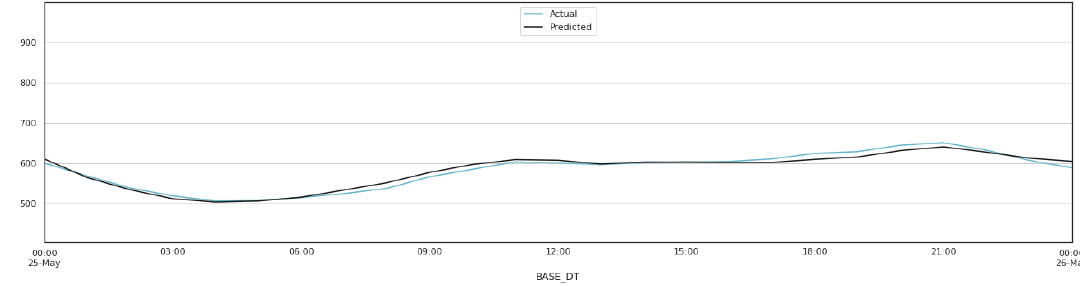
Figure 14. Forecasted load values for a single day (25 May